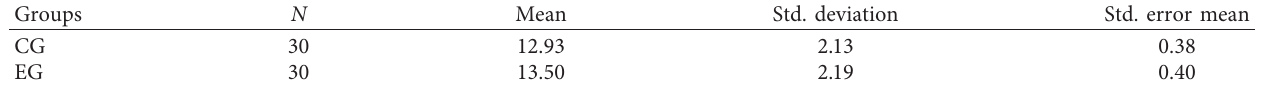
Table 1: Means and standard deviations of both groups on the reading comprehension